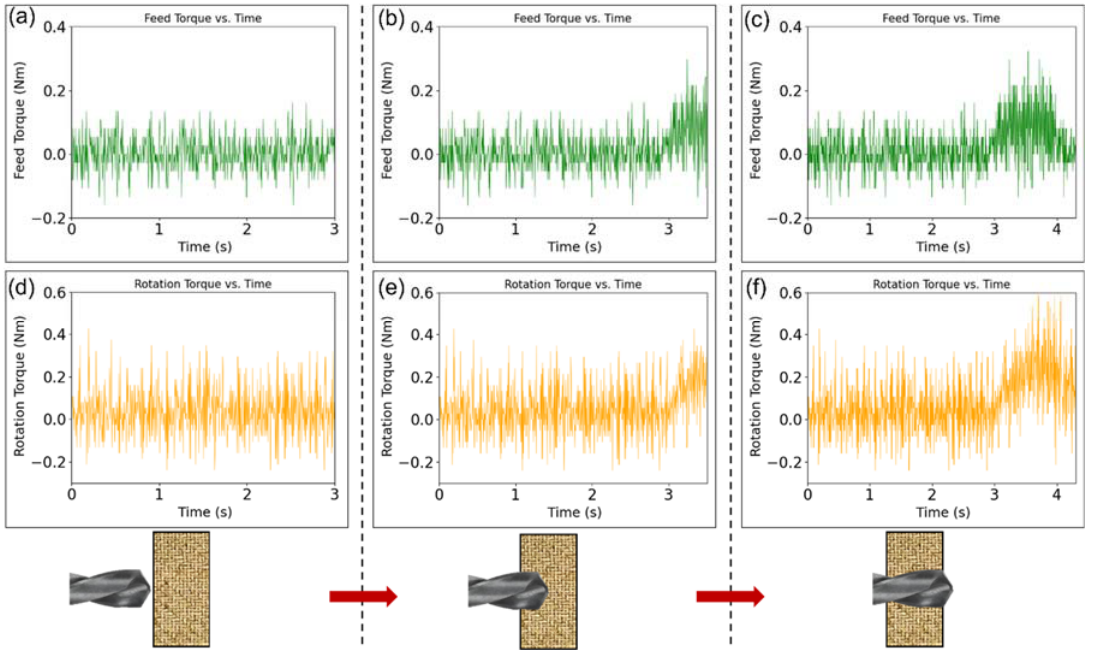
Figure 9. Real ‐ time data plots of feed torque ( a – c ) and rotation torque ( d – f ) in different drilling steps extracted from servo motors located in the end ‐ effector causing drilling feed and rotation motion, respectively.